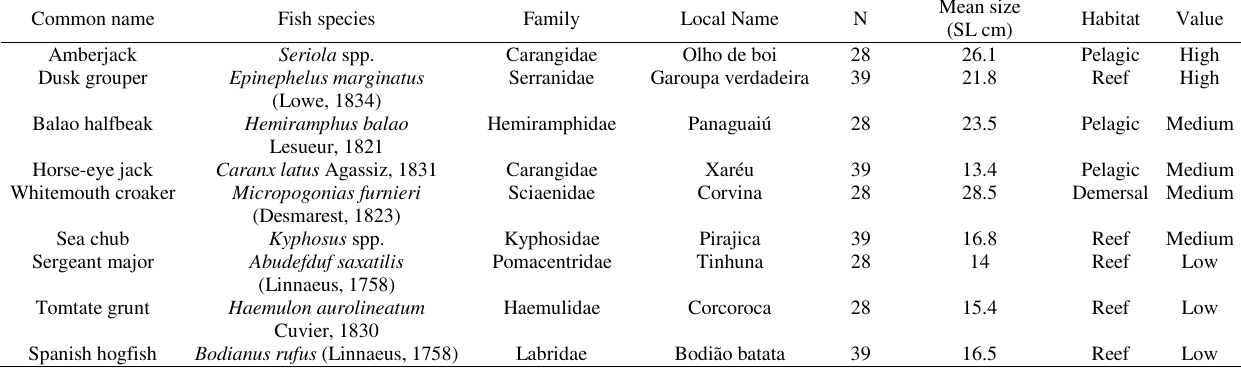
Table 1. Fish species addressed in interviews with Búzios Island fishermen: common name in English according to (Froese & Pauly, 2011), total number of interviewed fishermen (N), mean size based on measures of Standard Length (SL) of fishes at the study site, main habitat and estimated value for commerce and food (high, medium, low) based on previous surveys (Begossi, 1992, 1996; Begossi & Richerson, 1993; Begossi & Figueiredo, 1995). Common name of Seriola spp. and Kyphosus spp. corresponded to more than one species. Amberjack, dusk grouper and horse-eye jack measured were possibly juveniles.